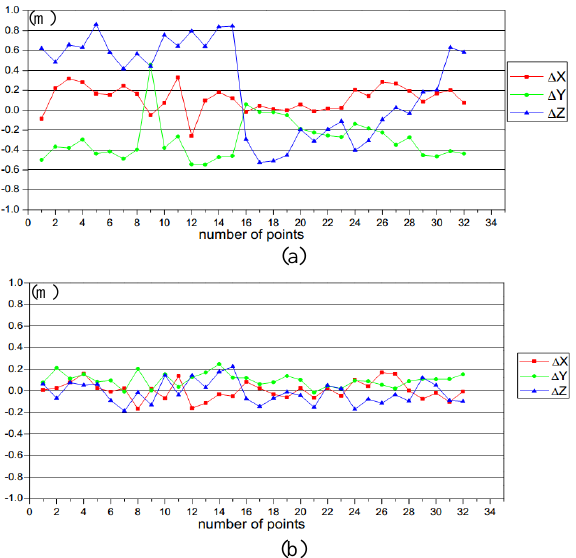
Figure 8. (a) Differences between control points and check points for the unadjusted data (RMS- △ X= 0.130m , RMS- △ Y= 0.211m , RMS- △ Z= 0.467m ). (b) Difference between control point and check point from corrected data (RMS- △ X= 0.086m , RMS- △ Y= 0.063m , RMS- △ Z= 0.106m